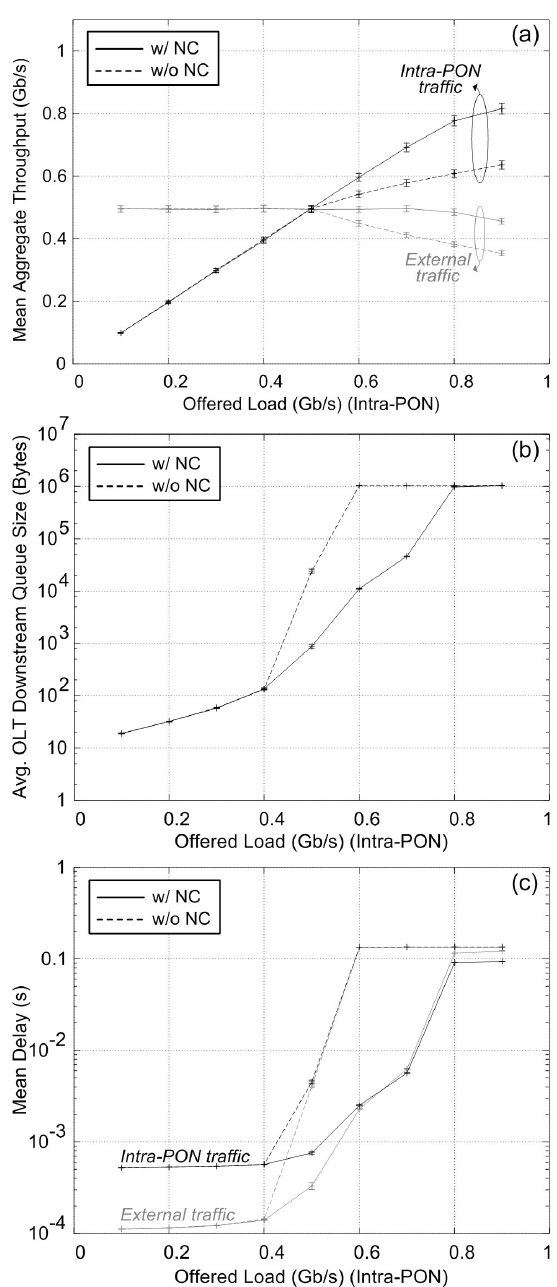
Figure 4. Performance enhancements of an EPON through network